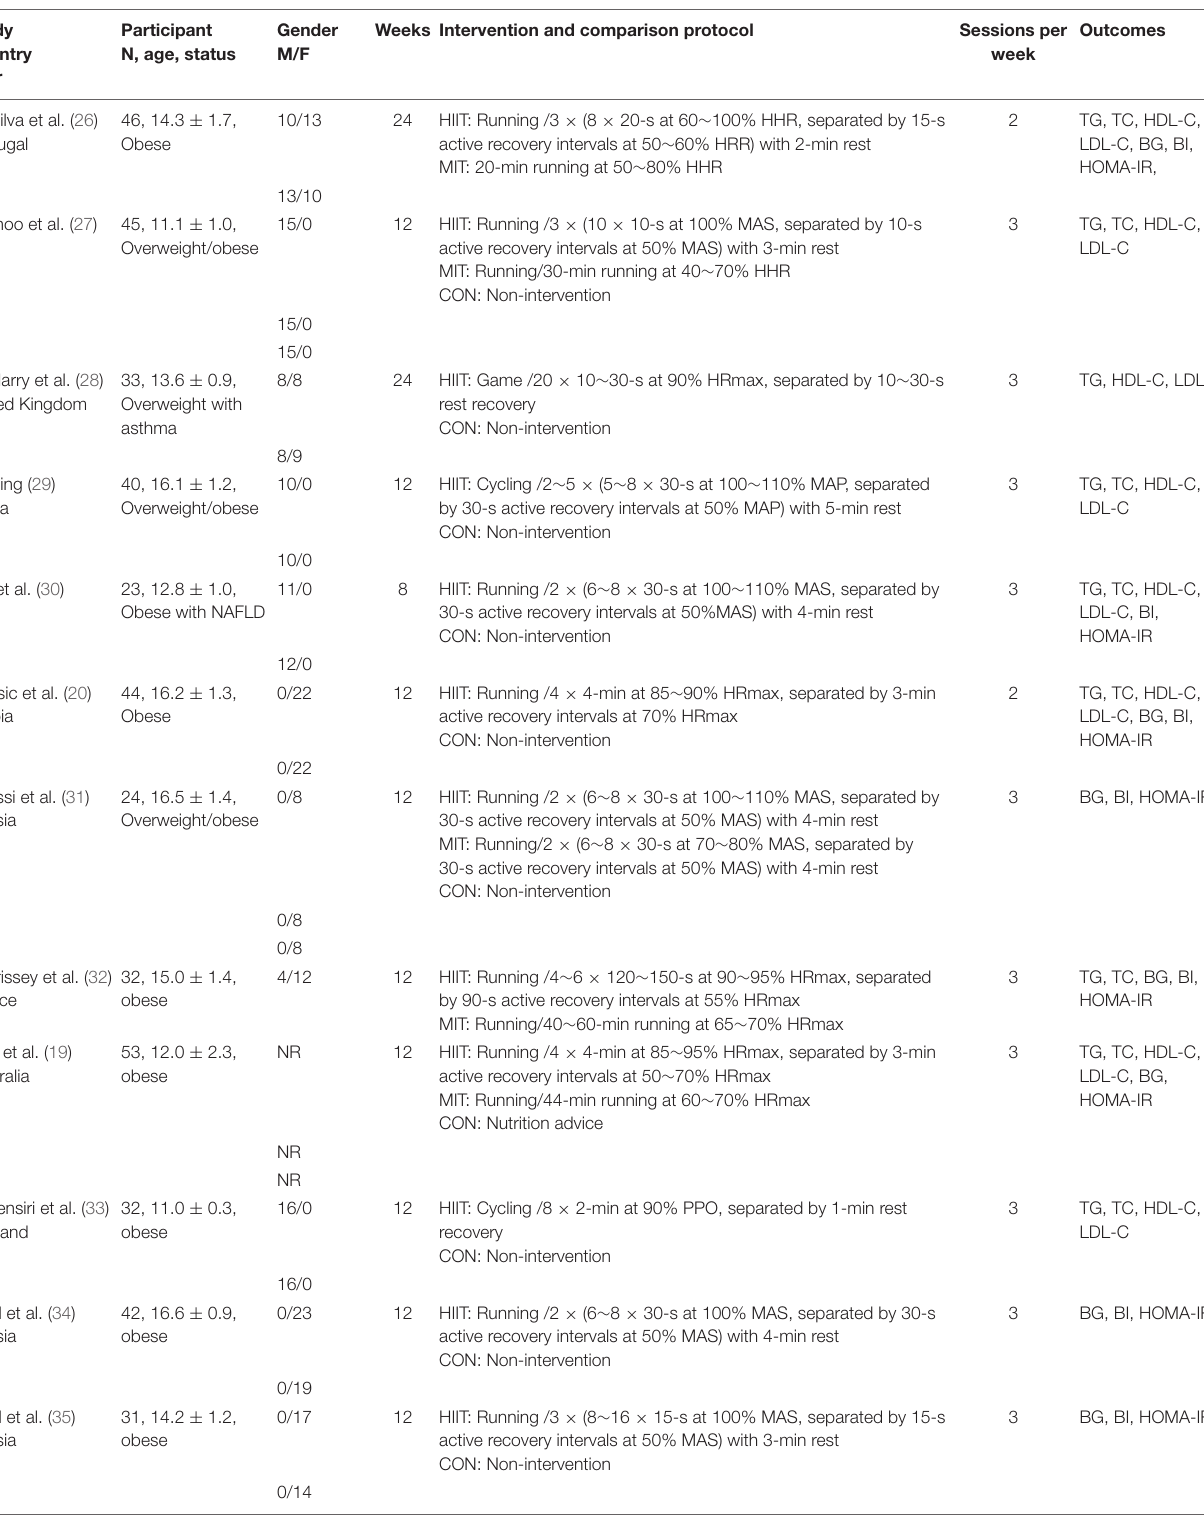
TABLE 2 | Included study characteristics and